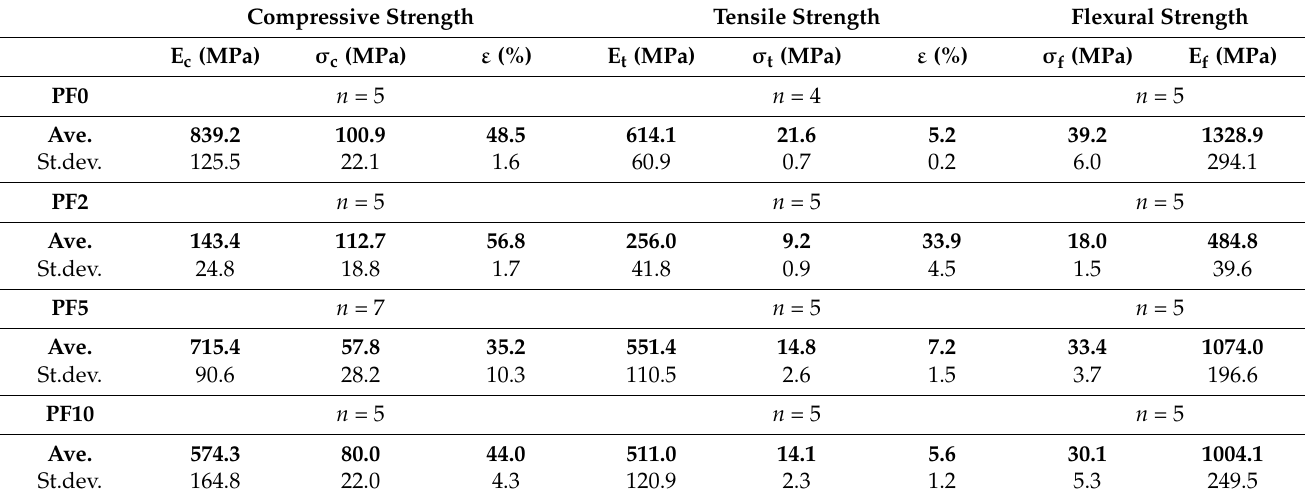
Table 3. Results of mechanical tests (compressive, tensile, and flexural strength) for the PF samples.